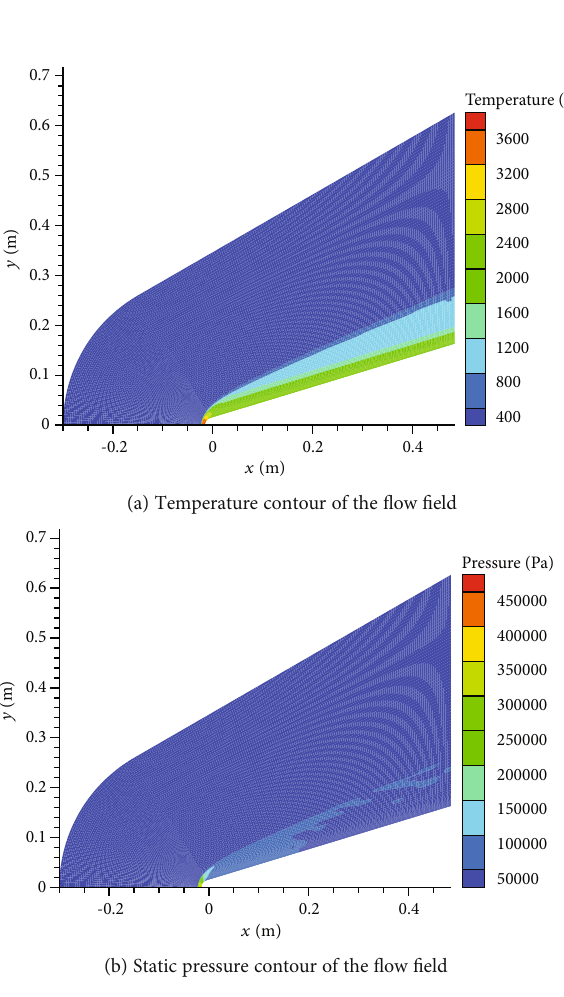
Figure 11: Flow features at 100